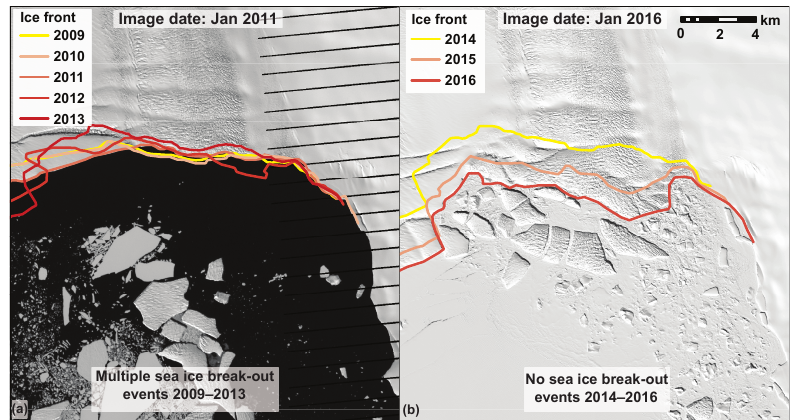
Figure 8. Relationship between ice front position of Cook West and the presence of landfast sea ice and mélange at its ice front. (a) Mapped ice front position overlain on a Landsat-7 image between 2009 and 2013, during which multiple sea ice break-out events were observed and there is little change in ice front position. (b) Mapped ice front position overlain on a Landsat-8 image between 2014 and 2016, during which no sea ice break-out events were observed and the ice front was able to advance. Note the build-up of ice mélange near the ice